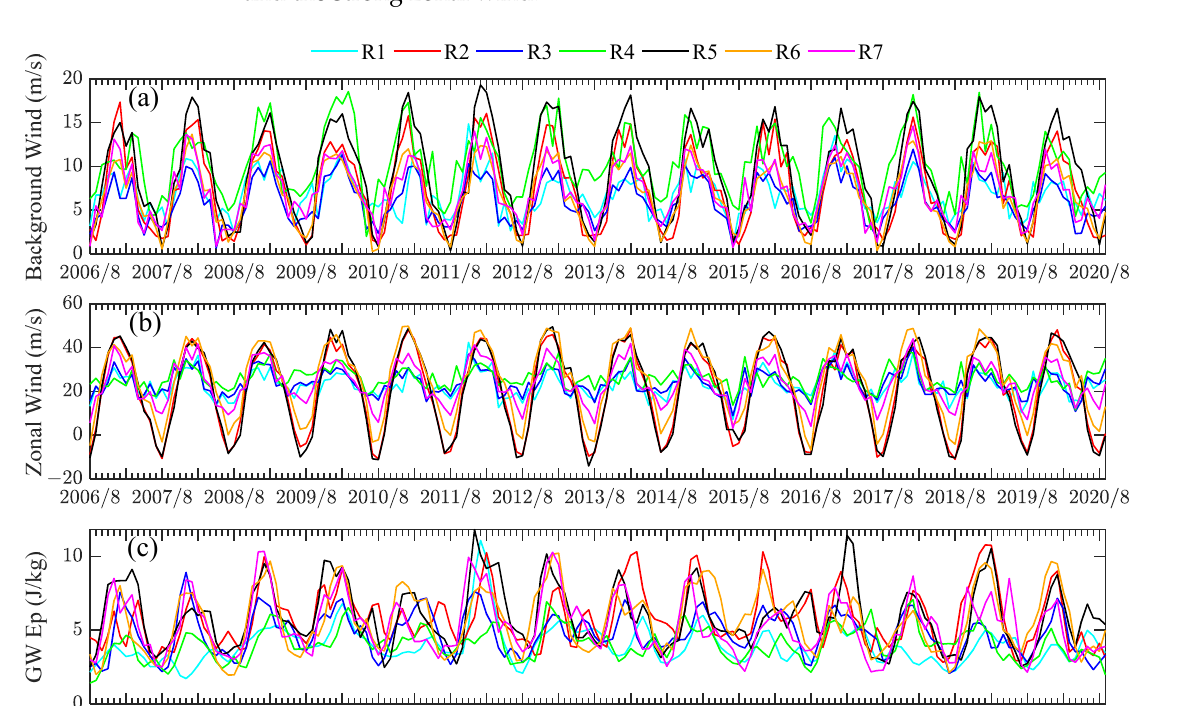
Figure 12. The time series of ( a ) the background wind, ( b ) the zonal wind (8~18 km), and ( c ) the GW Ep (18~20 km) in each region from August 2006 to September 2020. The background wind is the average value of the background wind within the elevation range of each region. The solid lines in cyan, red, blue, green, black, orange, and magenta represent the variables from Region #1 to Region #7, respectively.